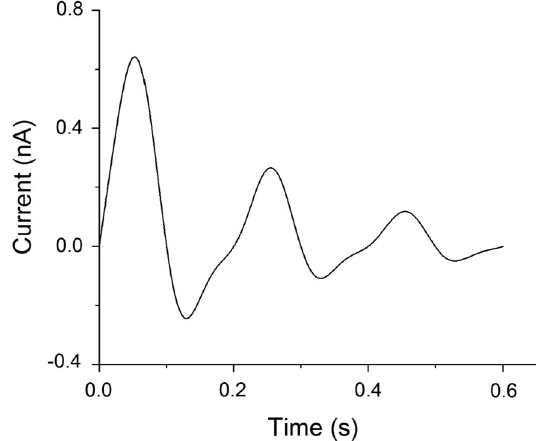
FIG. 16. The nonlinearity heuristically built into the dissipa- tion coefficient (cid:1) . The dissipation coefficient remains constant for shear rates (cid:8) less than a critical value (cid:8) c . Above the critical value, it increases with a linear dependence on the shear